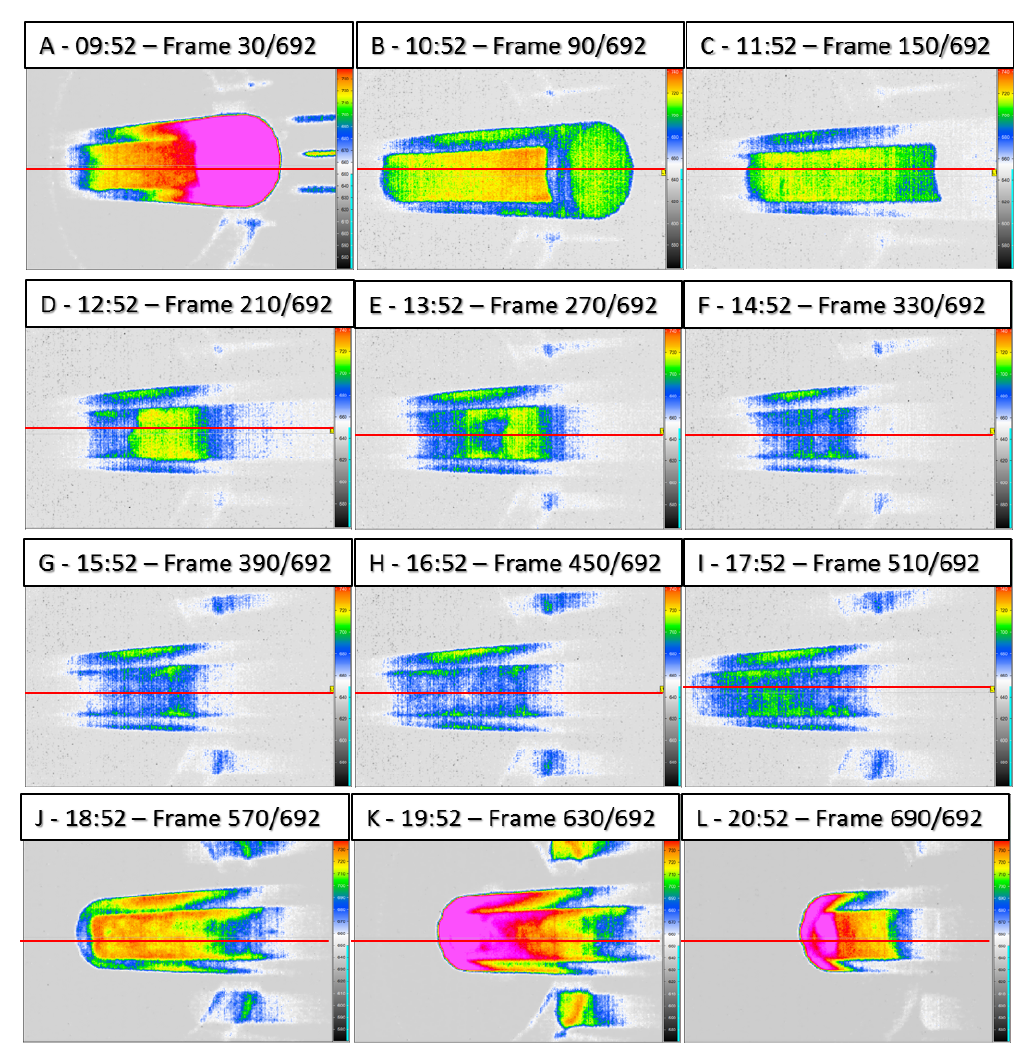
Figure 9. Thermographic image of every hour from start to finish of one pass of zone